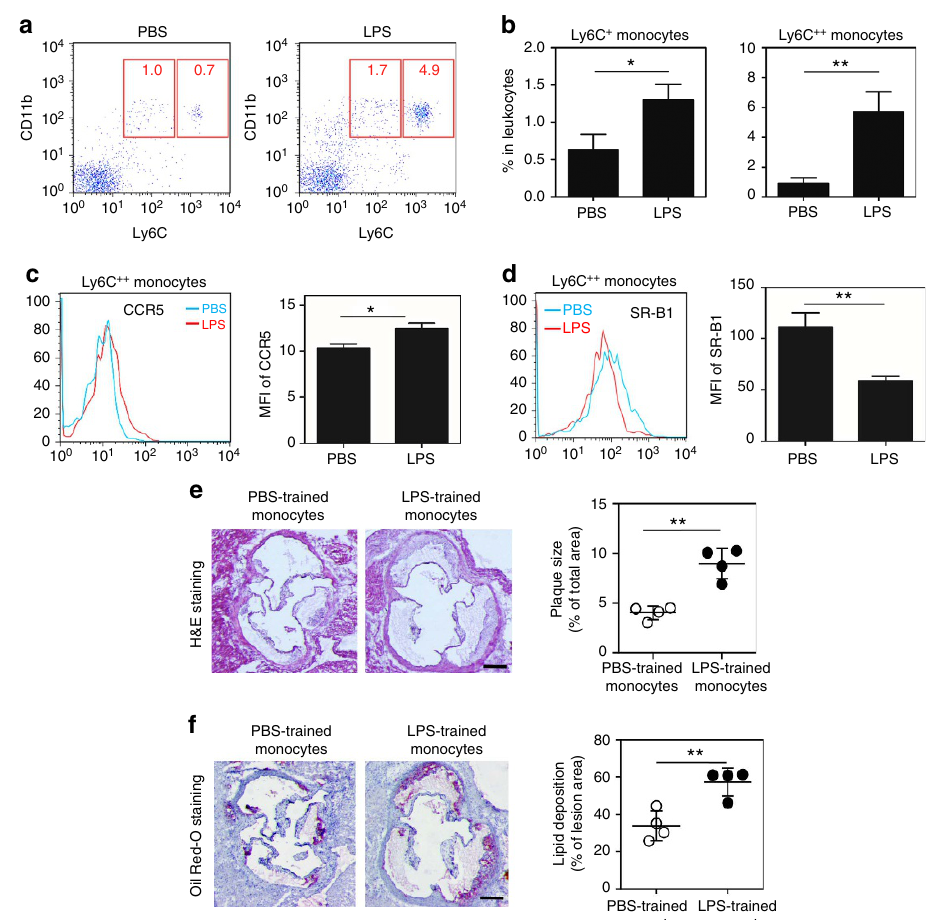
Figure 3 | Polarized inflammatory monocytes by subclinical endotoxin contributes to aggravated atherosclerosis. ApoE (cid:2) / (cid:2) mice were pre-conditioned with PBS or super-low-dose LPS for 4 weeks together with HFD, followed by HFD feeding only for an additional 4 weeks. ( a ) Peripheral blood cells were collected, and CD11b þ Ly6C þ þ and CD11b þ Ly6C þ monocytes gated within the Ly6G (cid:2) population were examined by flow cytometry. ( b ) The frequency of inflammatory monocytes within total leukocytes was quantified. Data are shown from PBS ( n ¼ 7) and super-low-dose LPS-conditioned ( n ¼ 7) mice. ( c ) The expression levels of CCR5 within circulating inflammatory monocytes were compared between PBS ( n ¼ 6) and LPS-conditioned ( n ¼ 6) mice. ( d ) The expression levels of SR-B1 within circulating inflammatory monocytes were compared between PBS ( n ¼ 6) and LPS conditioned ( n ¼ 6) mice. ( e , f ) Adoptive transfer of LPS-programmed monocytes exacerbates atherosclerosis. BM cells from ApoE (cid:2) / (cid:2) mice were cultured with M-CSF (10ngml (cid:2) 1 ) in the presence of PBS or LPS (100pgml (cid:2) 1 ) for 5 days. PBS- or LPS-programmed BM cells (3 (cid:3) 10 6 cells per mouse) were then adoptively transferred through intravenous injection to HFD-fed ApoE (cid:2) / (cid:2) mice once a week for 4 weeks. ( e ) Representative images of atherosclerotic plaques within aortic root areas stained by haematoxylin and eosin. Plaque sizes were quantitated as a percentage of the lesion areas within aortic root areas. Scale bar, 300 m m. ( f ) Representative images of atherosclerotic plaques within aortic root areas stained by Oil Red O. Scale bar, 300 m m. The lipid deposition areas as a percentage of the total atherosclerotic plaques within the aortic root areas were quantified. Data are presentative of two similar experiments. Error bars represent means ± s.e.m.; * P o 0.05 and ** P o 0.01; Student’s t